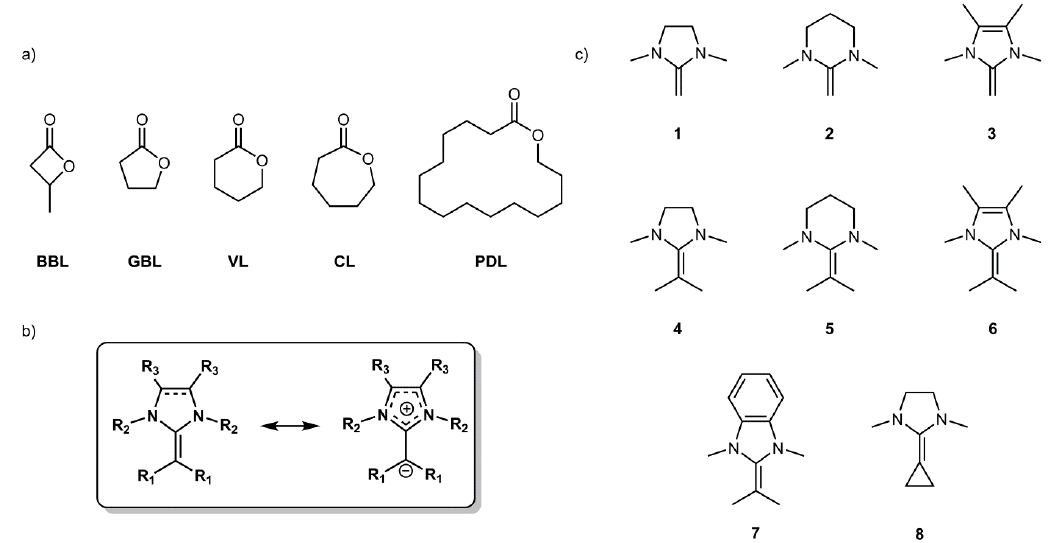
Figure 1. ( a ) Different lactones that have been polymerized by NHO/metal halide LPs; ( b ) mesomeric structure emphasizing the polarized character of the NHO double bond; ( c ) range of NHOs considered in this work. BBL: β -butyrolactone; GBL: γ -butyrolactone; VL: δ -valerolactone; CL: ε -caprolactone; PDL: pentadecalactone.